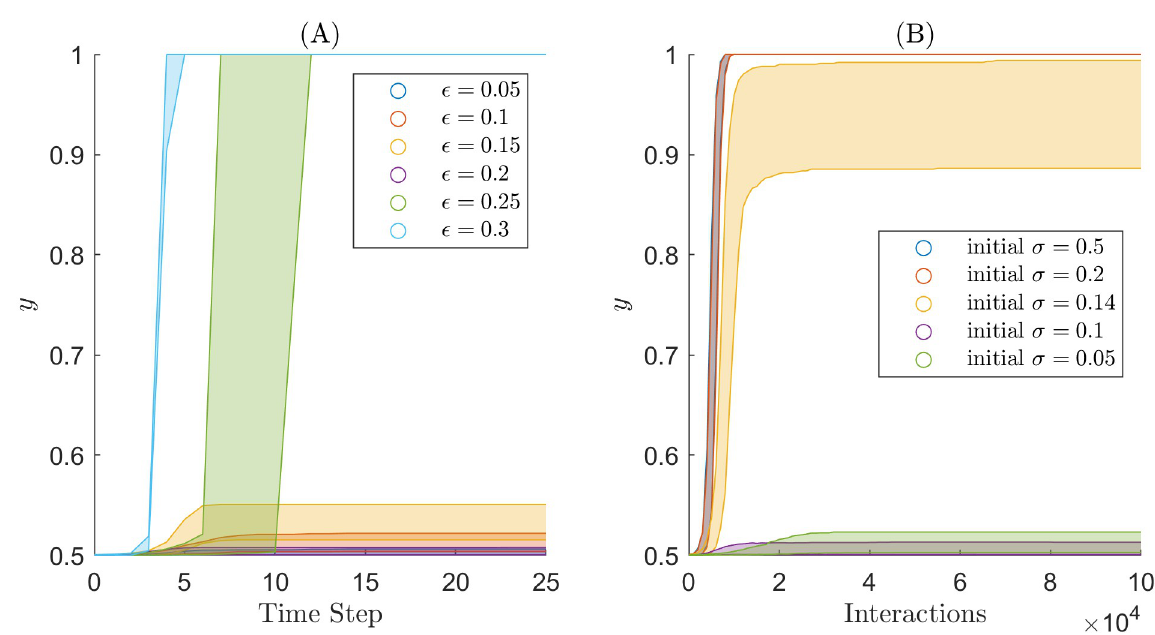
Table 2. The mean estimated opinion cluster count for each 100 simulations of the extended Martins model under different initial uncertainty. Initial Uncertainty 0.5 Standard Deviation 0.73 Cluster counts were found using the inbuilt Matlab function subclust .